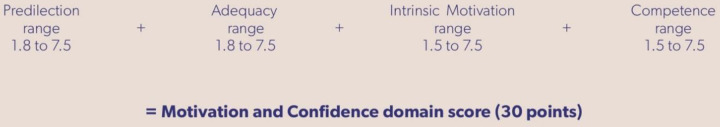
Formula for computing motivation and confidence score.Reprinted from www.capl-eclp.ca/capl-manual under a CC BY license, with permission from Healthy Active Living and Obesity Research Group, original copyright 2017.